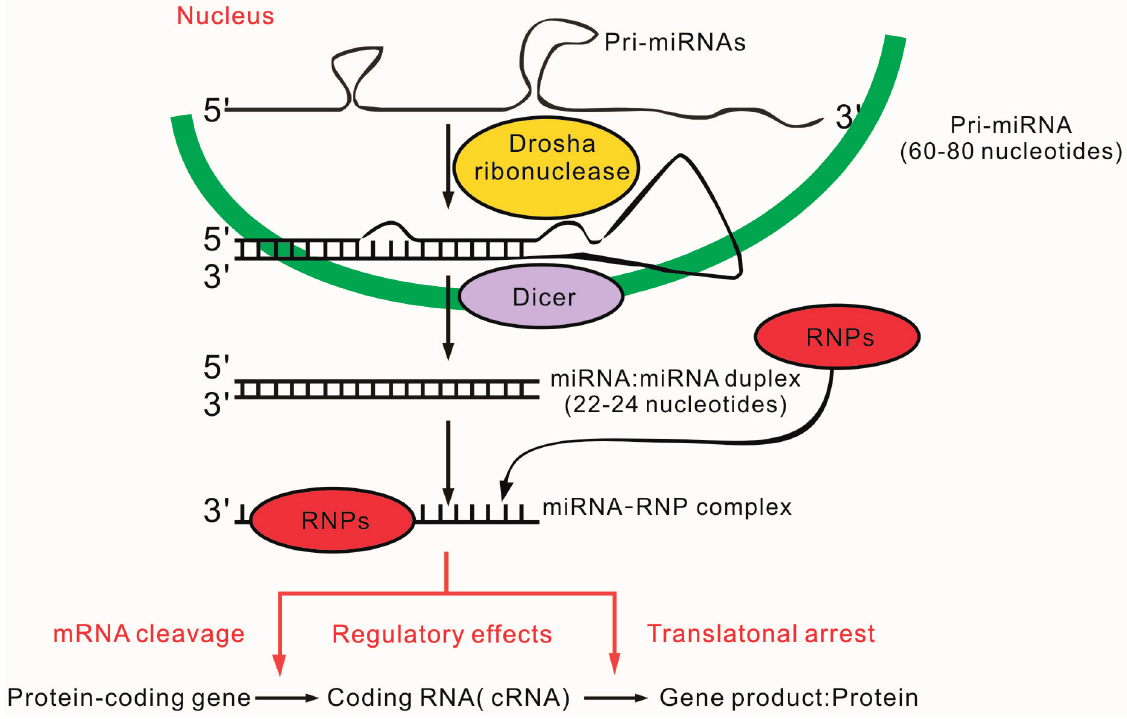
Figure 4. Gene regulation by miRNAs. miRNA genes are transcribed by RNA